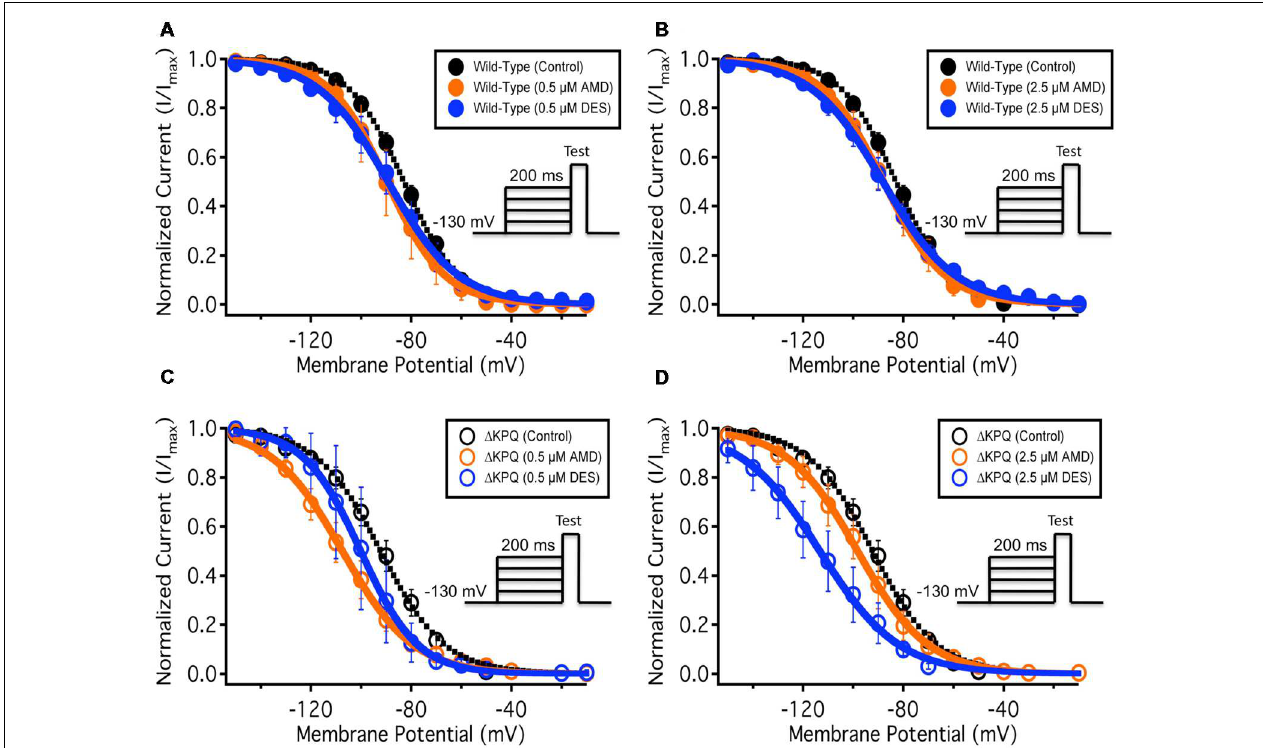
FIGURE 3 | (A–D) Show the voltage dependence of steady-state fast-inactivation as normalized current plotted against membrane potential. The black curves represent the WT Na v 1.5 or (cid:49) KPQ SSFI with no drug perfusion, the orange curves represent Na v 1.5 or (cid:49) KPQ SSFI after either 0.5 or 2.5 µ M AMD perfusion, and the blue curves represent Na v 1.5 or (cid:49) KPQ SSFI after either 0.5 or 2.5 µ M DES perfusion.